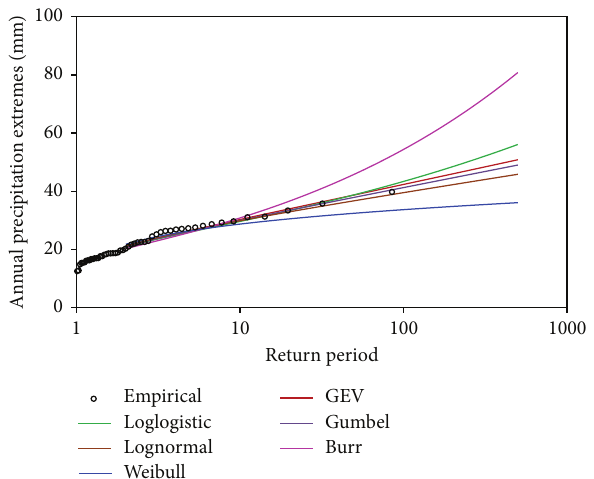
Figure 6: The empirical and the theoretical return levels in terms of different probability distributions for annual maximum precipi- tation of TL station.